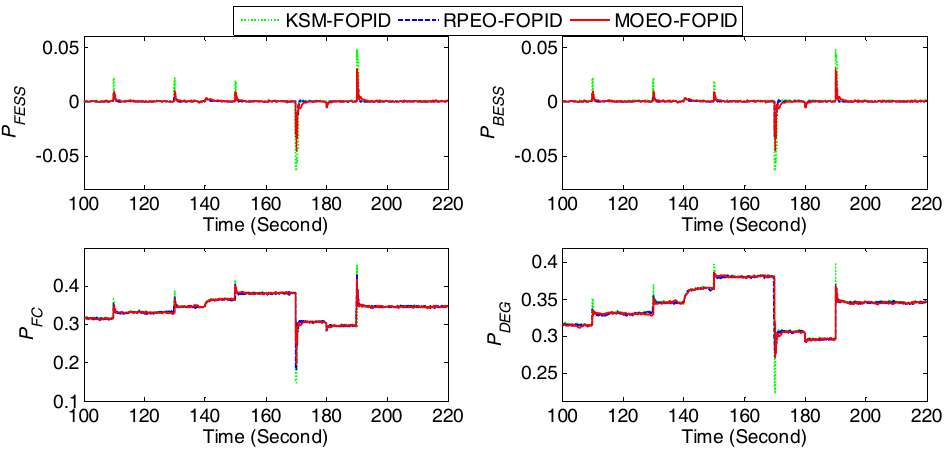
Figure 9. Comparison of individual powers in different components of the test microgrid with FOPID controllers obtained by MOEO and single-objective optimization algorithms including KSM and RPEO.